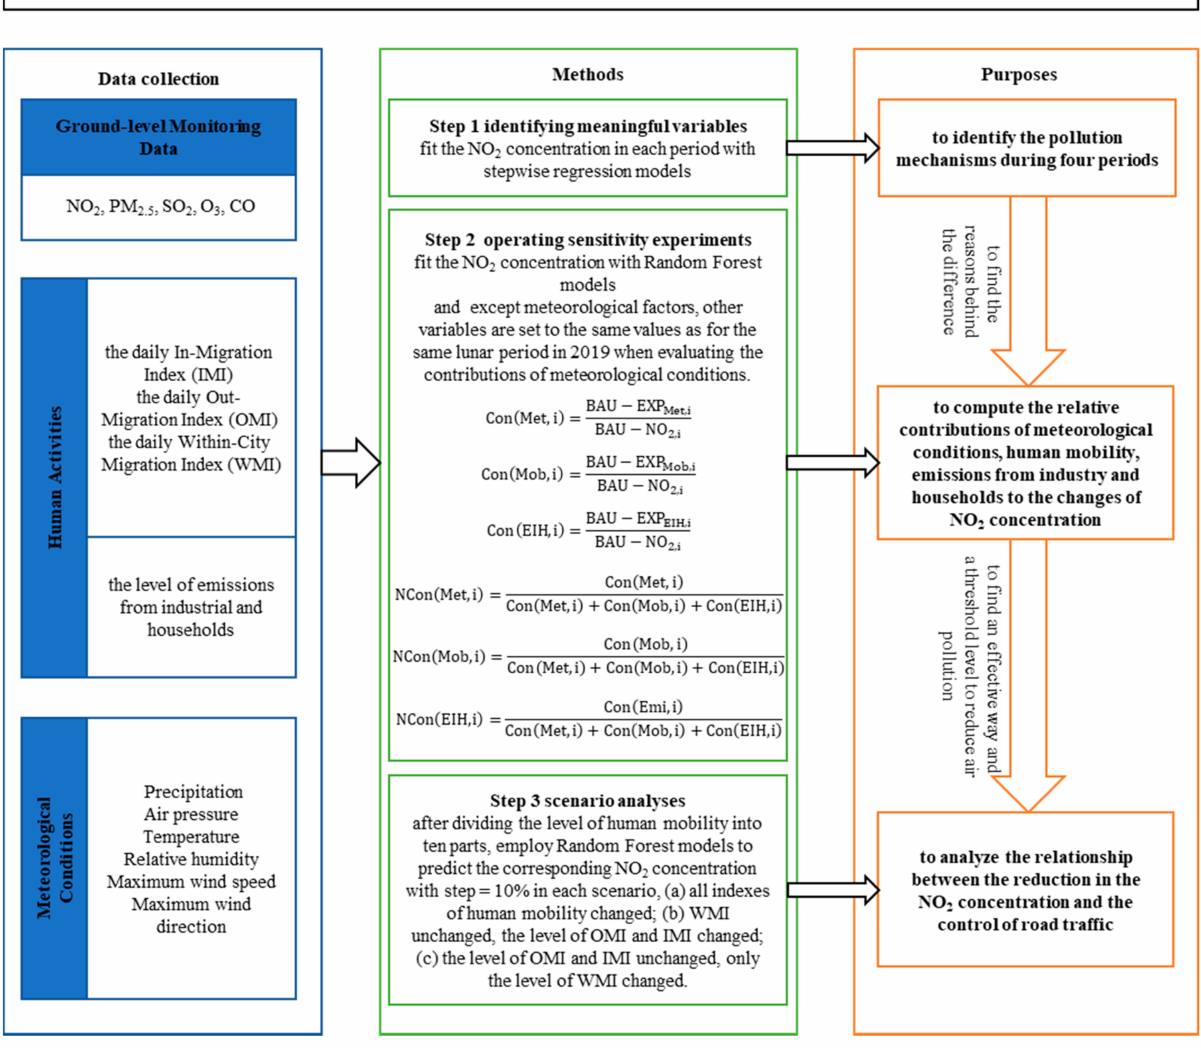
Figure 2. The flowchart of